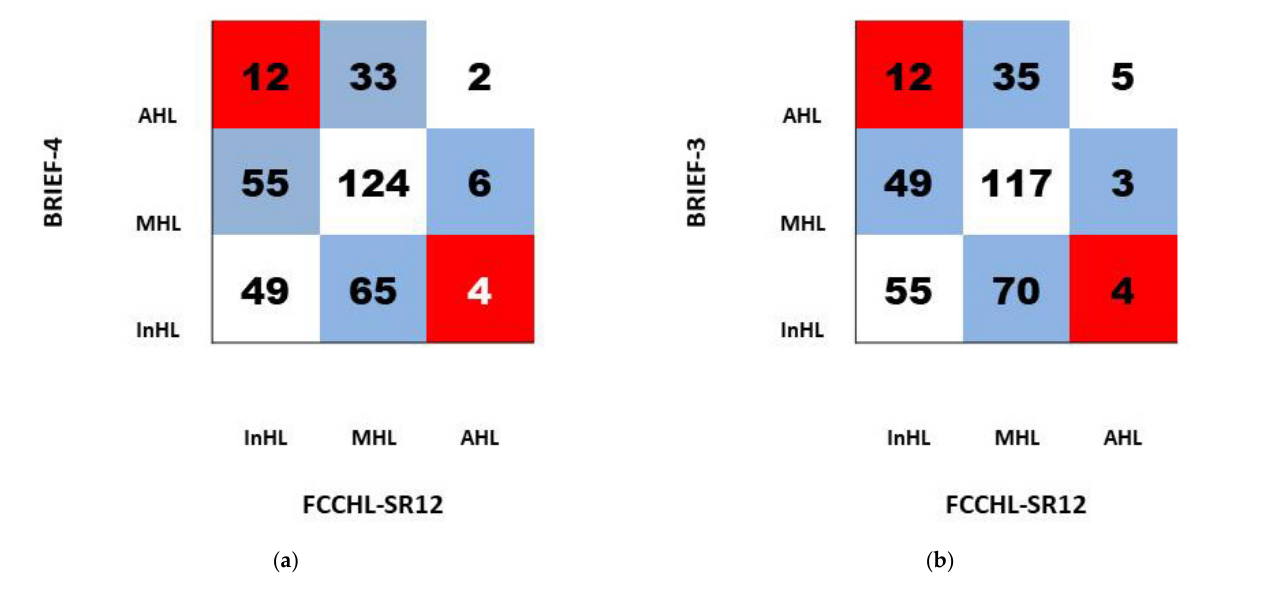
Figure 2. The white boxes show the number of respondents selected similarly with both FCCHL-SR12 and BRIEF-4 ( a ) or FCCHL-SR12 and BRIEF-3 ( b ) instruments. The blue boxes represent HL levels overestimated or underestimated by BRIEFs compared to FCCHL-SR12 for one level of knowledge. Red boxes represent overestimated or underestimated HL levels by BRIEFS for two levels of knowledge. AHL—adequate health literacy, MHL—marginal health literacy, InHL—inadequate health literacy.